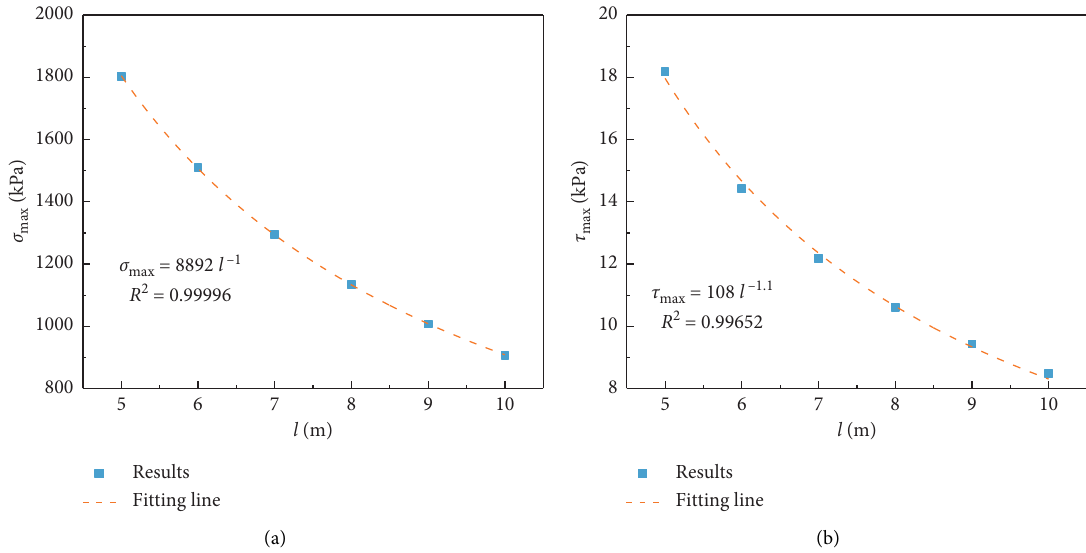
Figure 13: Effects of different transition lengths on the maximum normal stress (a) and maximum shear stress (b) of the dangerous section when the frost heave amount Δ �